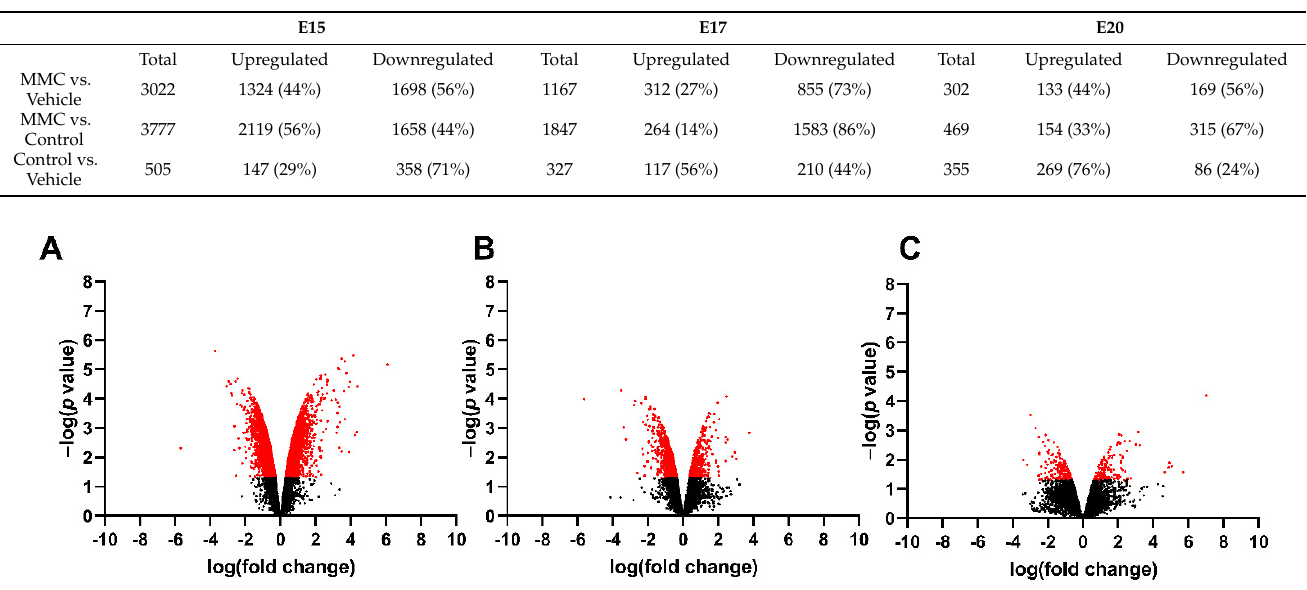
Figure 3. Volcano plot illustrating RNA-seq data of fetal spinal cords isolated from MMC and control at ( A ) E15, ( B ) E17, and ( C ) E20. Red identifies genes that were greater than 1.5-fold change and p < 0.05.